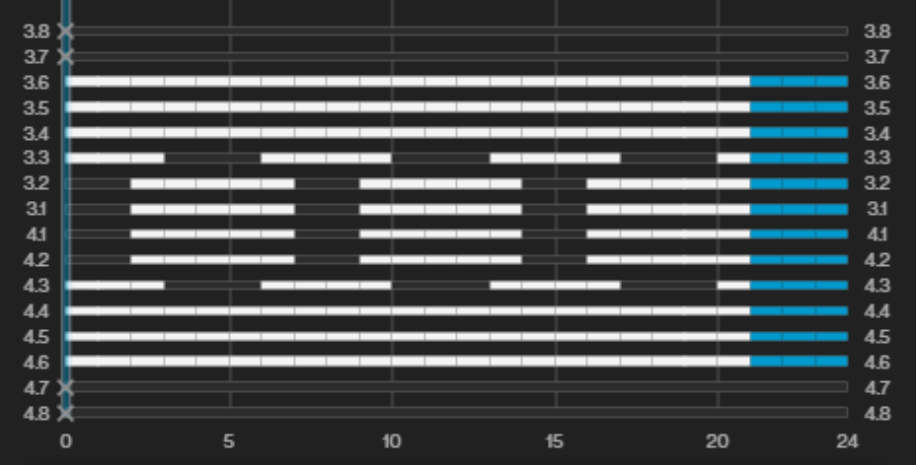
Figure 8. Frog staging.